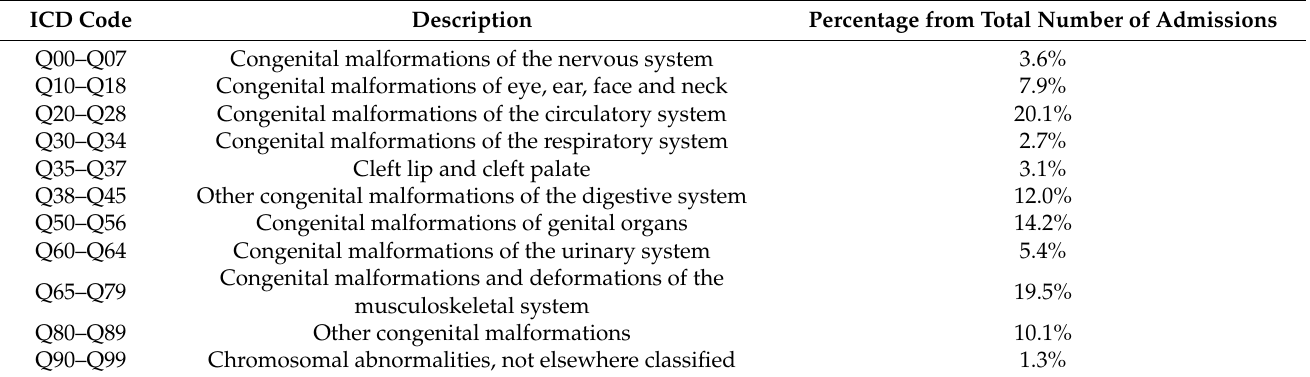
Table 1. Percentage of congenital malformations, deformations and chromosomal abnormalities hospital admission from total number of admissions per ICD code. ICD